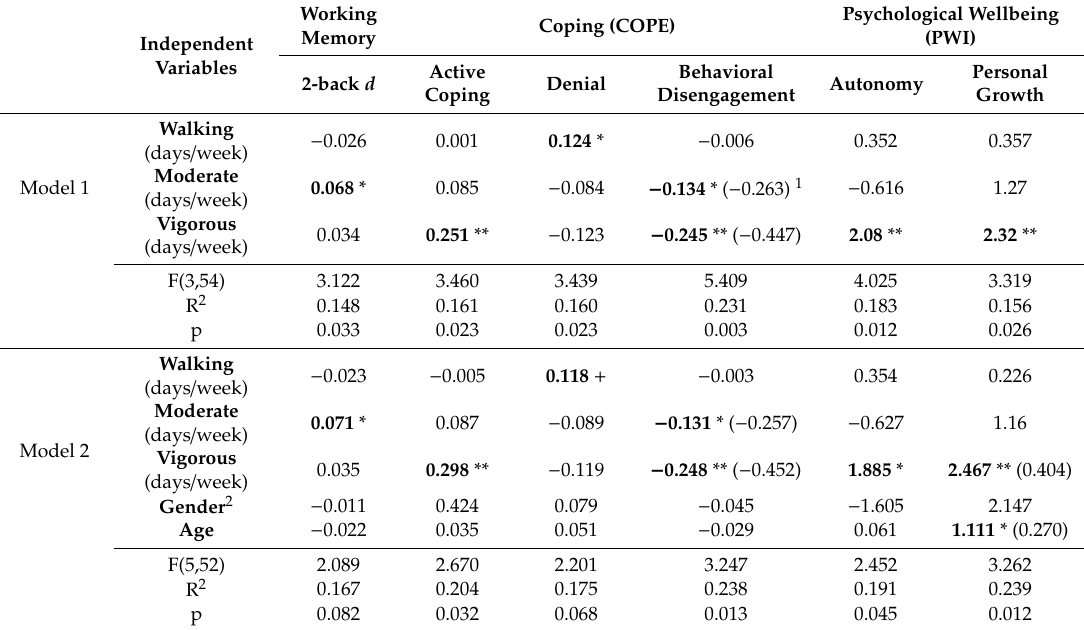
Table 2. Linear regression results using intensity-specific frequencies to predict measures of coping and psychological